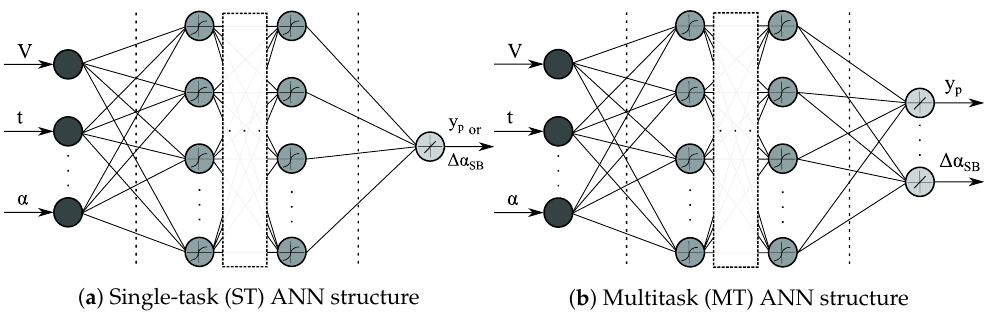
Figure 14. Structure of the neural networks considering ( a ) single task (ST) and ( b ) multitask (MT) formulations.